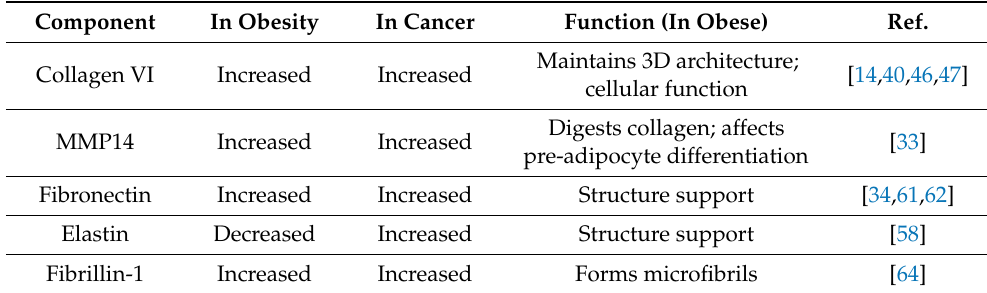
Table 1. The main components in obesity-related ECM